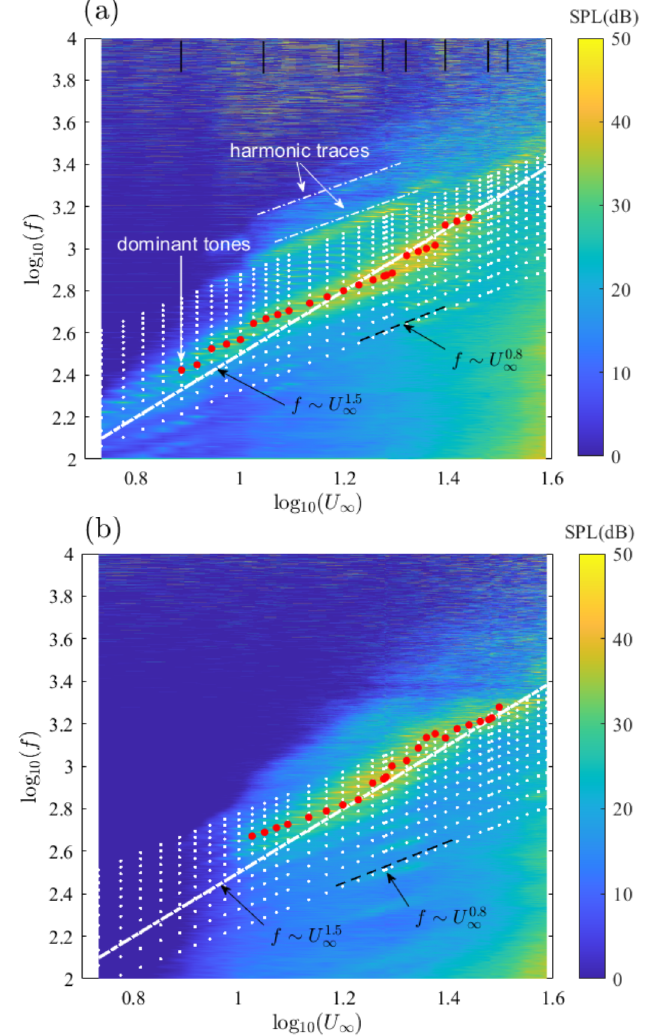
Figure 7. Frequency-flow speed maps of noise radiation for clean airfoils: NACA-0012 at zero AOA ( a ), SD7003 airfoil at 2° geometrical AOA ( b ). [15].